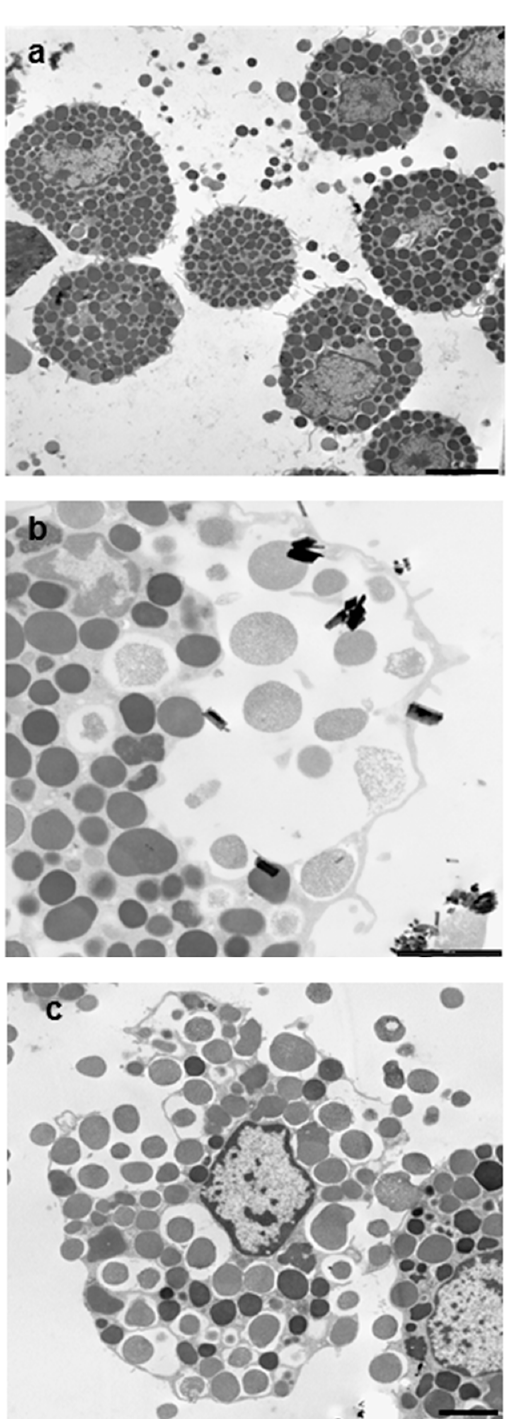
Figure 5. Transmission electron microscopy appearance of RPMC exposed to 100 μ g/mL of crocidolite fibers. ( a ) The unstimulated RPMC population; ( b , c ) a crocidolite-stimulated RPMC. After 30 min of incubation the secretory process appears to follow two pathways. In some cases, the secretion appears